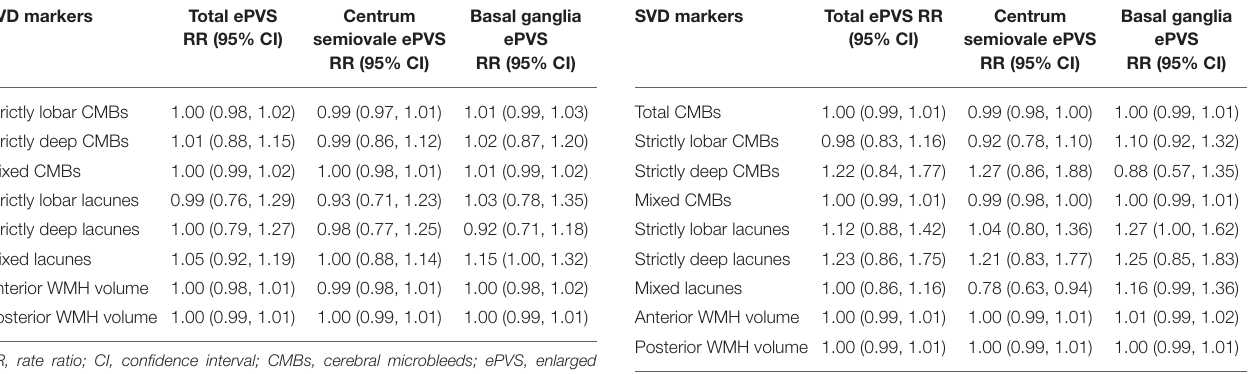
TABLE 5 | Association between location of SVD and ePVS (EDIS